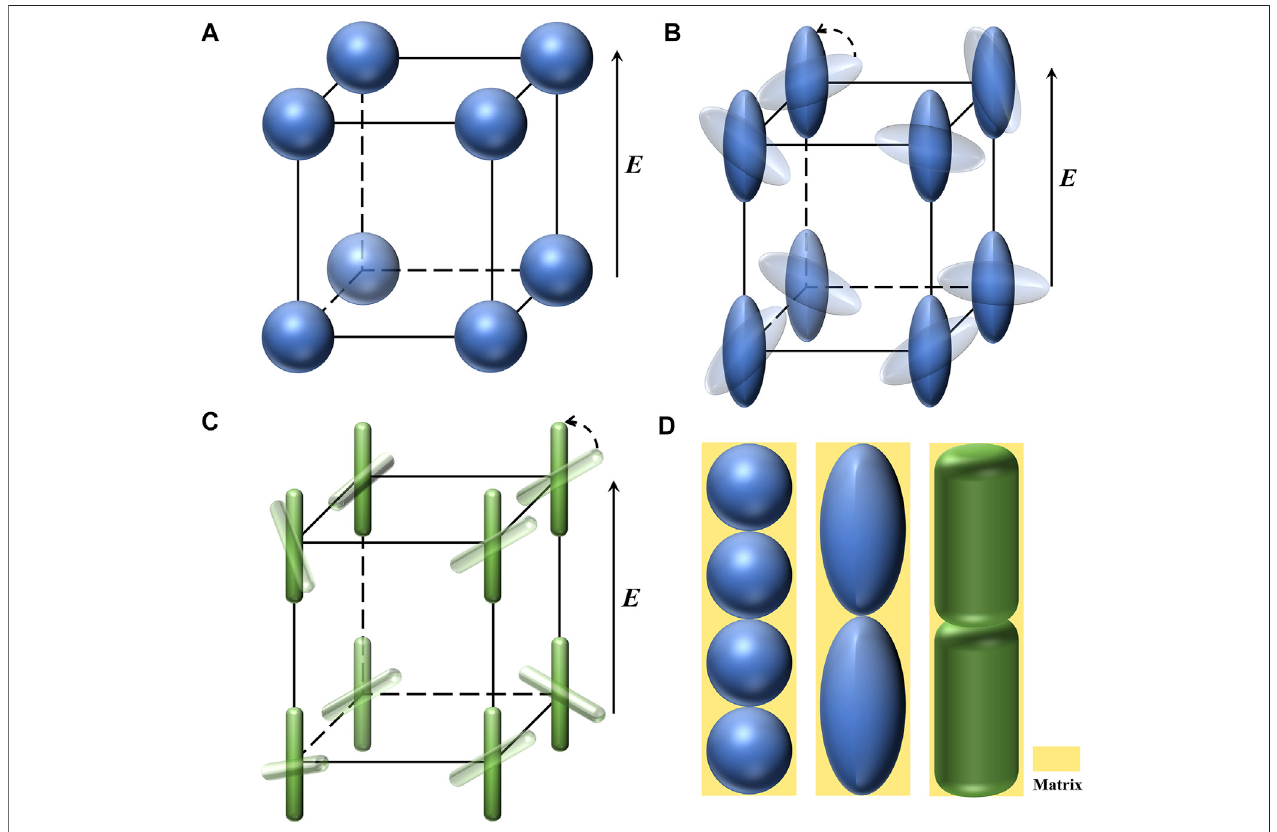
FIGURE 2 | Orientation and self-assembly of fi llers (A), spheres (B), ellipsoid (C), and rod-like particle (D) fully aligned along the electric fi eld.